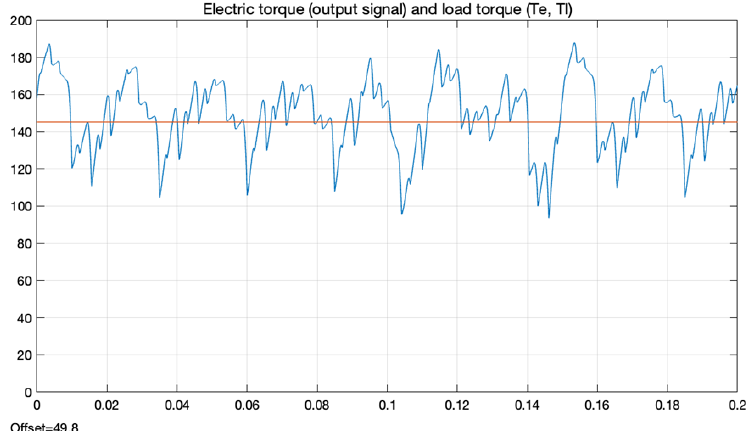
Figure 20. Zoomed electromagnetic torque (blue) M e (Nm) with the Simulink model of the IM drive and load torque (orange) M l (Nm) input to models during simulation.